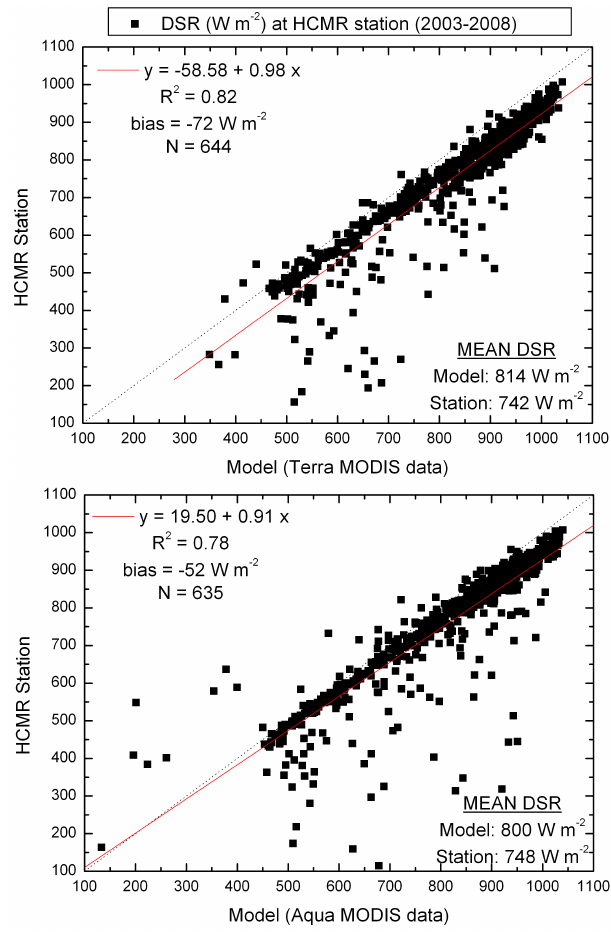
Fig. 4. Scatter plots of the model instantaneous DSR using MODIS Terra (a) and Aqua (b) data, against corresponding ground mea- surements from the HCMR station, for the years 2003–2008. The lines are the linear regression fits, with the equations, determination coefficients, biases, number of points and mean DSR values